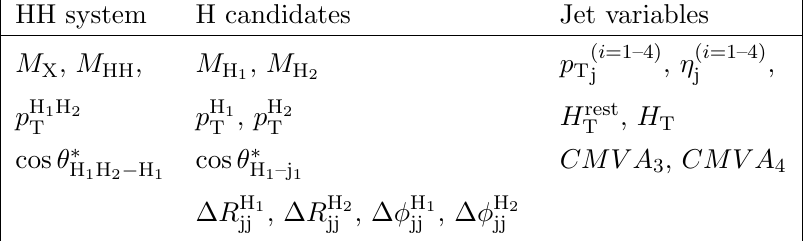
Table 3 . List of BDT input